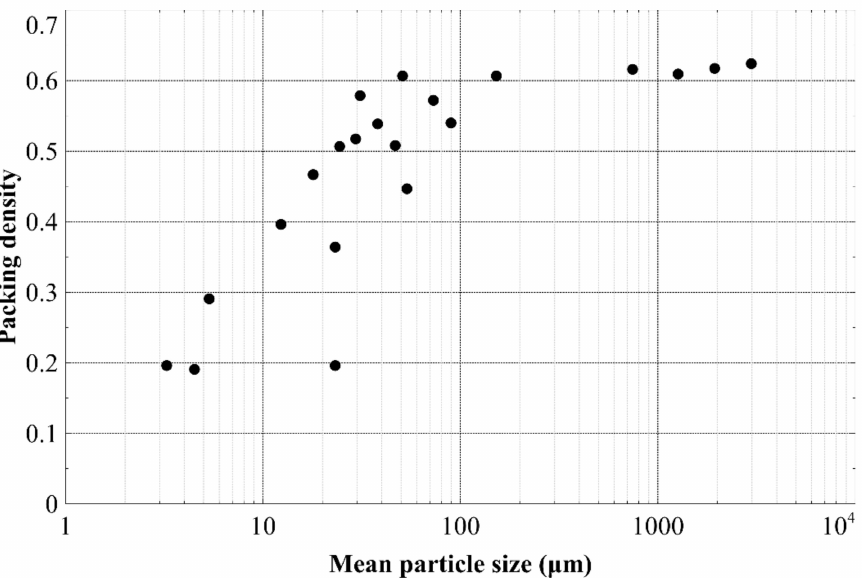
Figure 3. Measured packing density of relatively uniformly sized particles of different mean diame- ters. Data adapted from